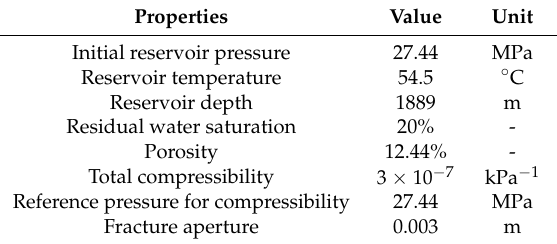
Table 1. Reservoir and fracture properties used in the field-scale shale-gas model.